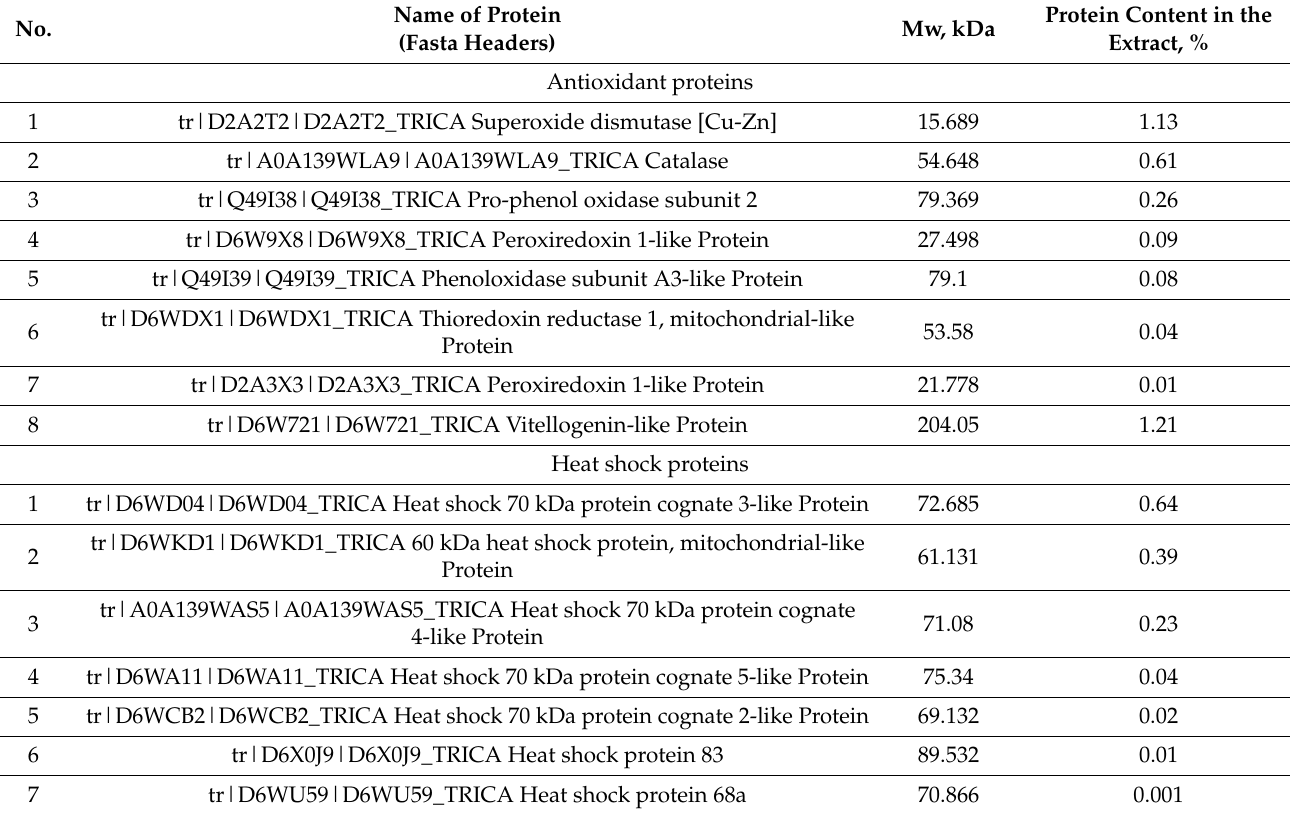
Table 1. Proteins identified by homology—antioxidants and heat shock proteins in an aqueous extract of the U. der- mestoides beetle.